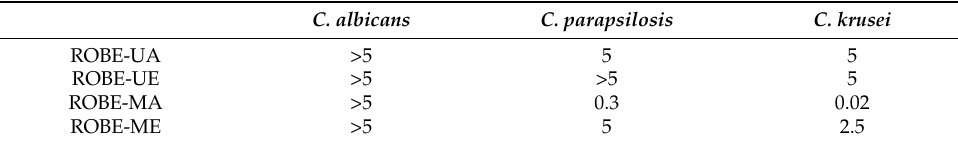
Table 3. Antifungal activity (MIC in mg/mL) of the ROBEs.